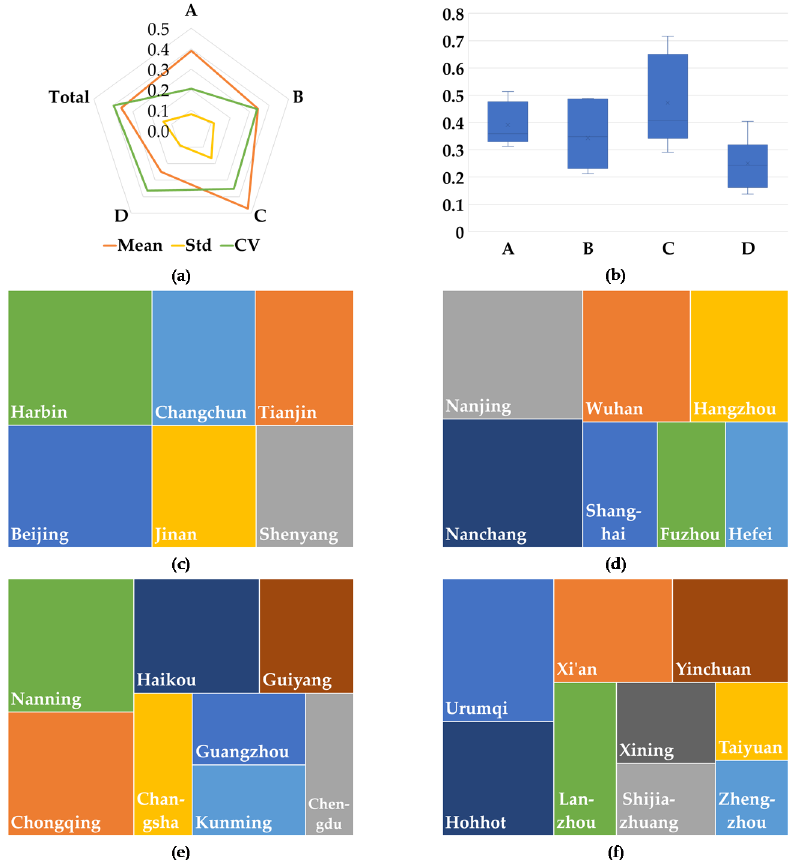
Figure 12. Detailed statistics of UGEI for four regions (i.e., Regions A–D): ( a ) statistical results of UGEI, ( b ) boxplots of UGEI in Regions A, B, C, and D, ( c ) UGEI of cities in Region A, ( d ) UGEI of cities in Region B, ( e ) UGEI of cities in Region C, and ( f ) UGEI of cities in Region D.